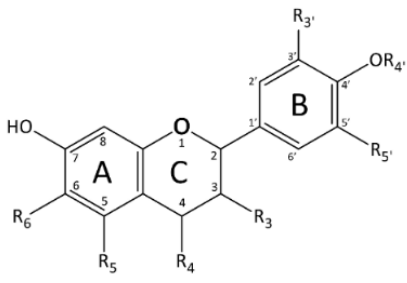
Figure 1. Basic structure of flavonoids.